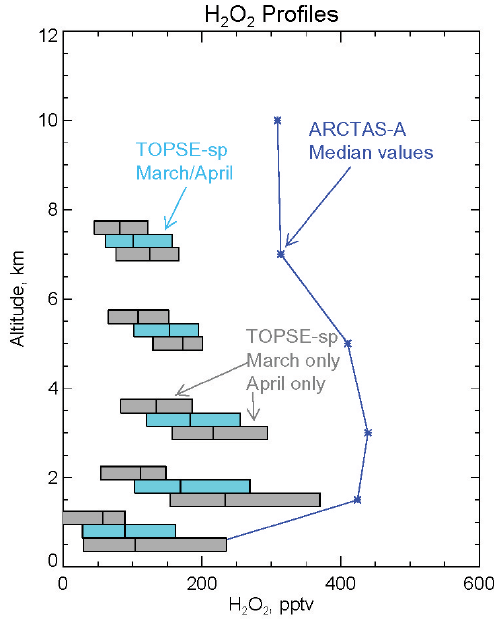
Fig. 6. Median observations of H 2 O 2 during ARCTAS-A and dur- ing TOPSE-sp, using combined March/April data versus March only and April